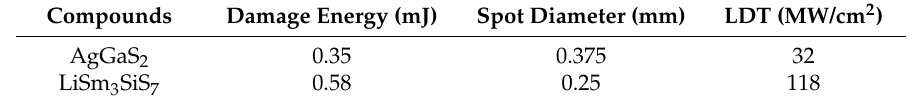
Figure 2. Optical properties (infrared (IR), bandgap, and Raman) of LiSm 3 SiS 7 . Table 2. Laser-damage thresholds (LDTs) of LiSm 3 SiS 7 and AgGaS 2 (as the reference).